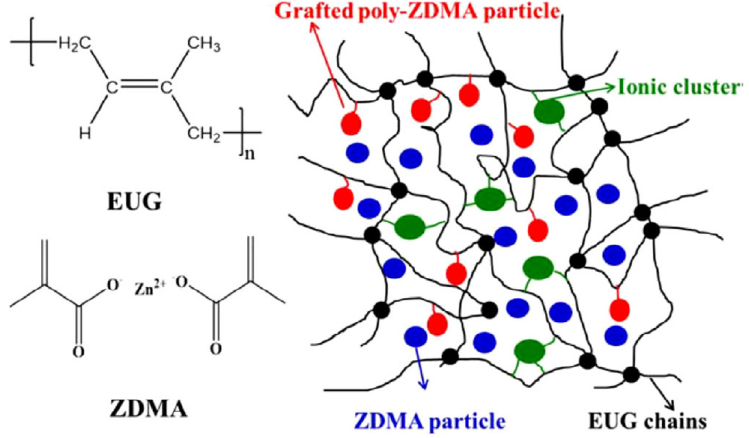
Figure 12. The interaction of EUG chains with ZDMA particles is depicted in this illustration. (Reproduced with permission from [113], Wiley, 2020).